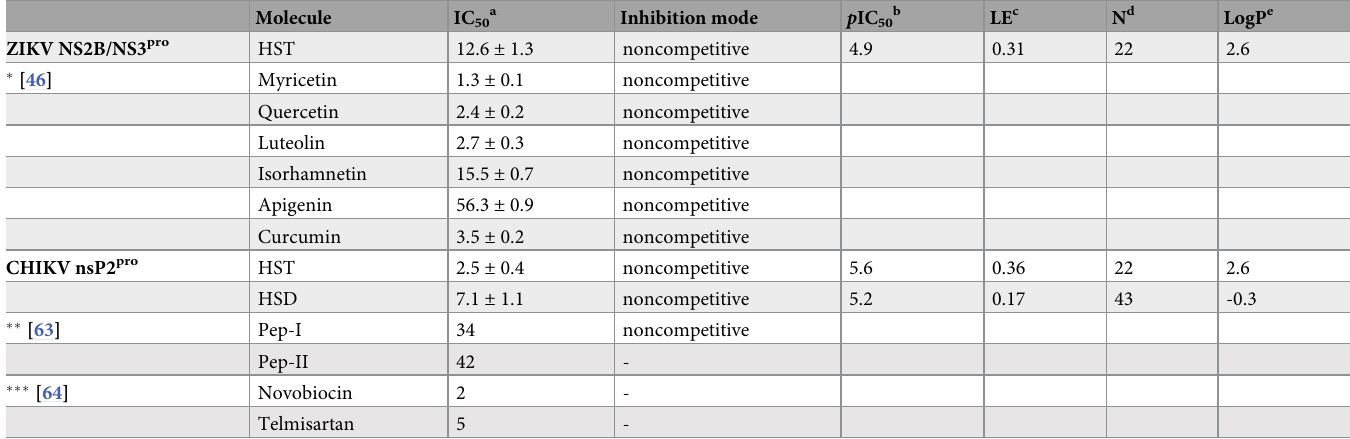
Table 1. Results summarize HST and HSD inhibition experiments of ZIKV NS2B/NS3 pro , and CHIKV nsP2 pro